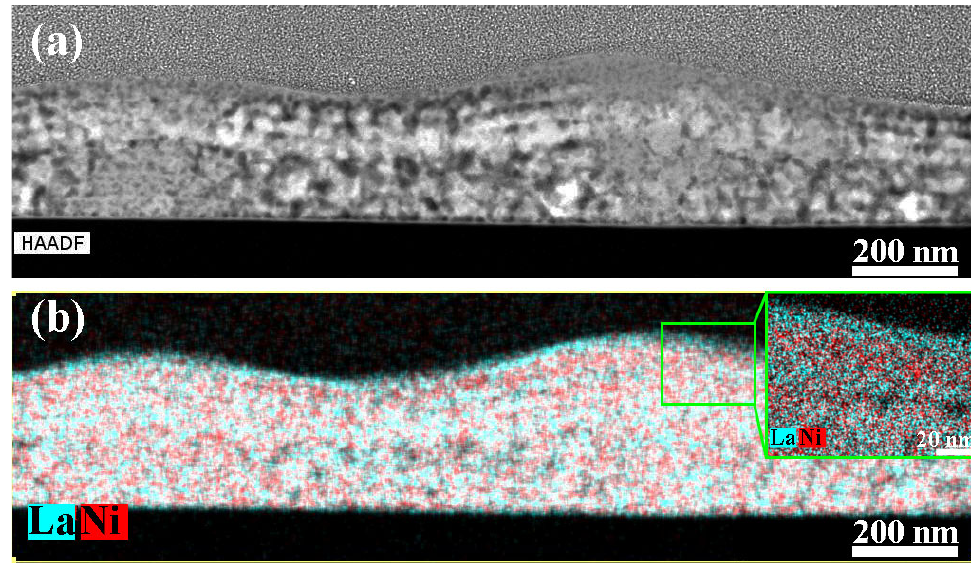
Figure 2. HAADF STEM image ( a ) and elemental maps ( b ) of LNO ‐ cryst ‐ 2 min sample.